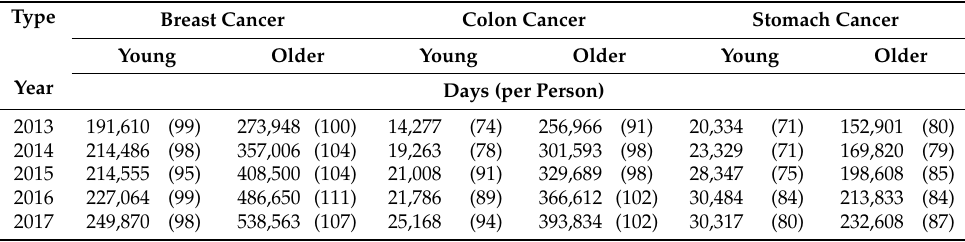
Table 3. Visit days for women cancer survivors in convalescent hospitals by age group between 2013 and 2017.